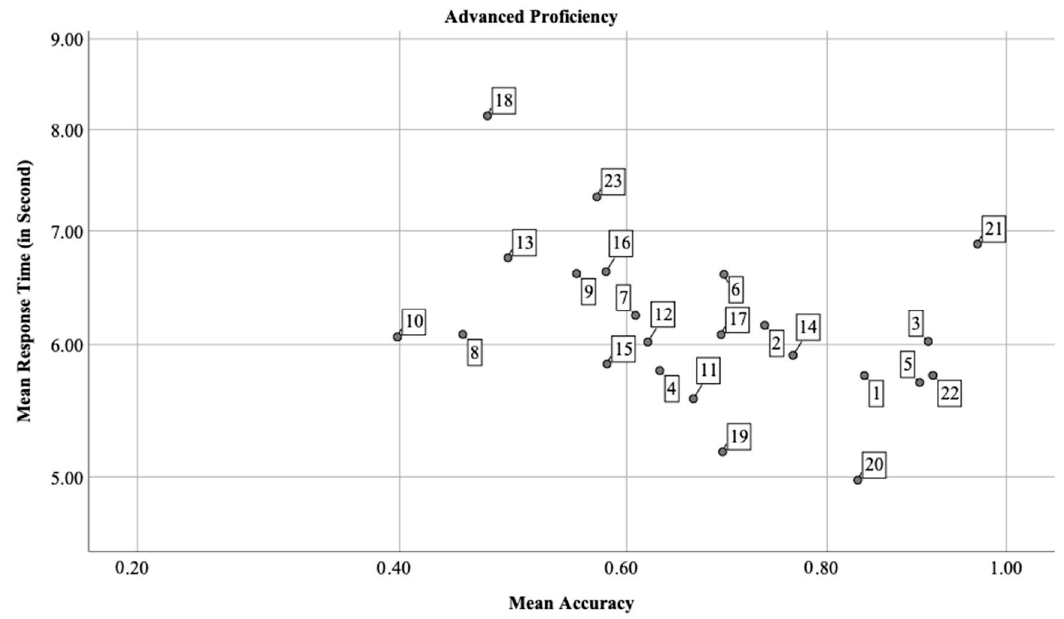
Figure 4. Scatterplot of cues (accuracy by response time) in the advanced group.